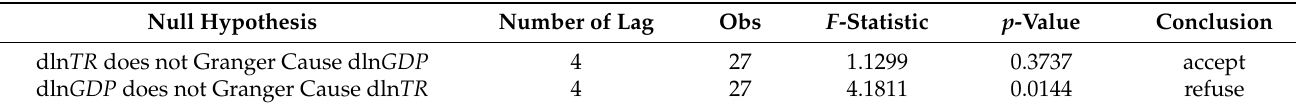
Table 4. Granger causality test.